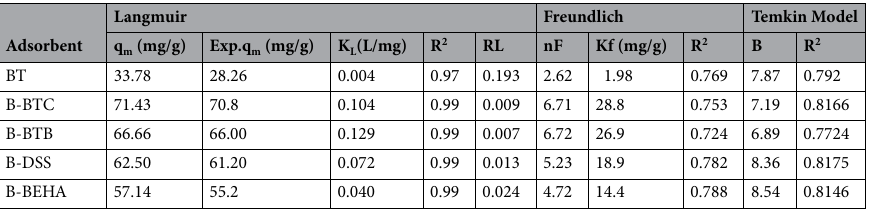
Table 2. Isotherm studies for the adsorption of DBT onto modified bentonite.